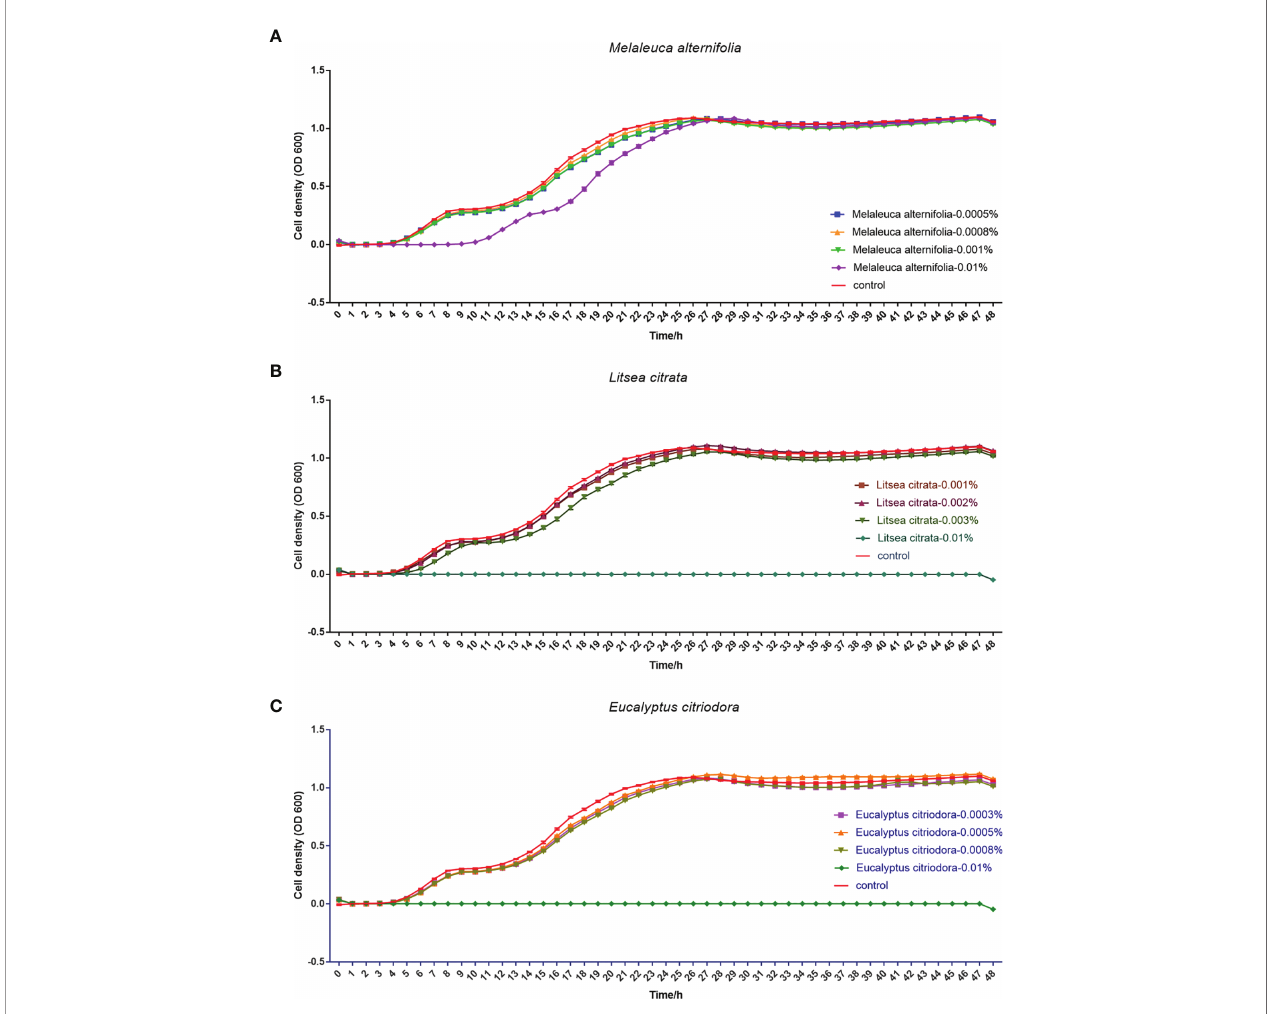
FIGURE 7 | Regrowth curve of Vibrio campbellii after incubation with or without essential oil Melaleuca alternifolia (A) , Litsea citrata (B) , and Eucalyptus citriodora (C) at different concentrations for 1 h. The group of essential oil M. alternifolia at the concentrations of 0.0005, 0.0008, 0.001, and 0.01%; the group of essential oil L. citrata at the concentrations of 0.001, 0.002, 0.003, and 0.01%; and the group of essential oil E. citriodora at the concentrations of 0.0003, 0.0005, 0.0008, and 0.01%. The control group contained 1% DMSO. Error bars represented the standard error of four